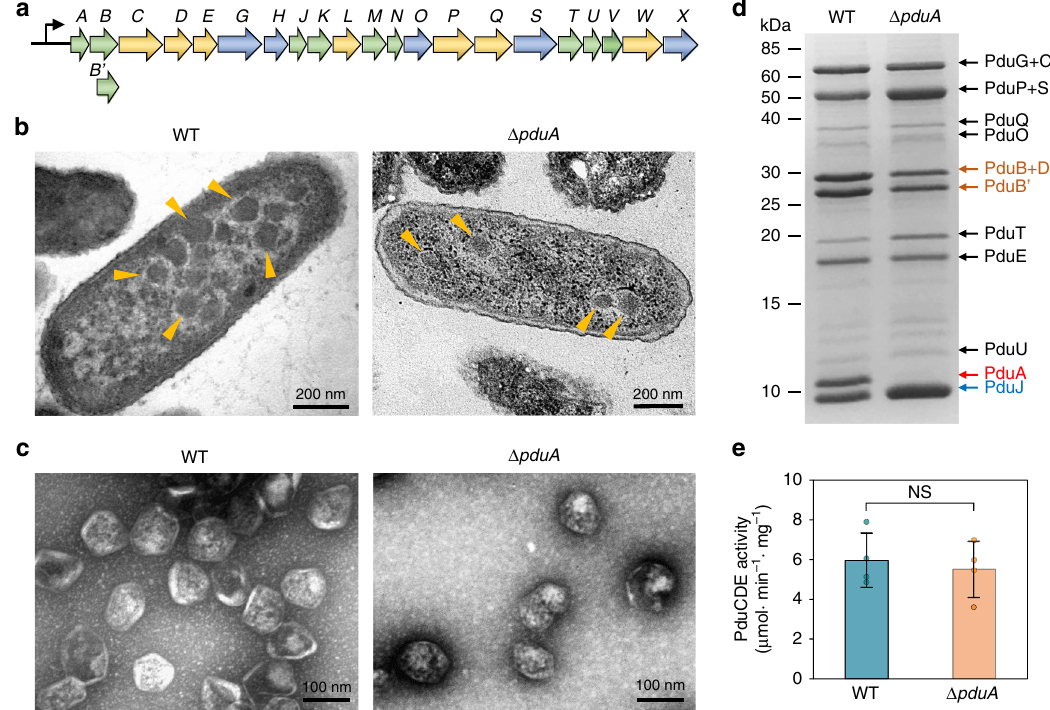
Fig. 1 The Pdu microcompartments and their isolation from S . Typhimurium LT2. a Diagram of the pdu operon, which encodes structural genes ( pduABB ’ JKMNTU ) and catalytic genes ( pduCDELPQW for 1,2-PD degradation and pduGHOSX for B 12 recycling) of the Pdu MCP. b Thin-section transmission electron microscopy of the WT and Δ pduA cells showing the presence of Pdu MCPs (yellow arrows). c Negative staining TEM images of puri fi ed Pdu MCPs from the WT and Δ pduA cells, demonstrating the structural integrity of isolated Pdu MCPs. d SDS-PAGE of puri fi ed Pdu MCPs from the WT and Δ pduA cells, revealing the polypeptide composition. PduA was detected in the WT Pdu MCPs but was absent in the Δ pduA Pdu MCPs (red arrow), con fi rming the genetic deletion of pduA . PduJ possesses an elevated abundance in the Δ pduA Pdu MCPs compared to the WT form (blue arrow), whereas the content of PduB, PduB ′ , and PduD in the Δ pduA Pdu MCPs were reduced (yellow arrows). e PduCDE (diol dehydratase) activity of puri fi ed Pdu MCPs from the WT and Δ pduA cells, demonstrating the functional integrity of isolated Pdu MCPs. The WT and Δ pduA Pdu MCPs had similar propanediol dehydratase (PduCDE) activity normalised by the total protein amount of the samples ( p = 0.651, n = 4, two-sided t test). The centre for error bars represents the mean, and error bars represent SD. n number of biologically independent experiments. Source data of Fig. 1e is provided as a Source Data fi